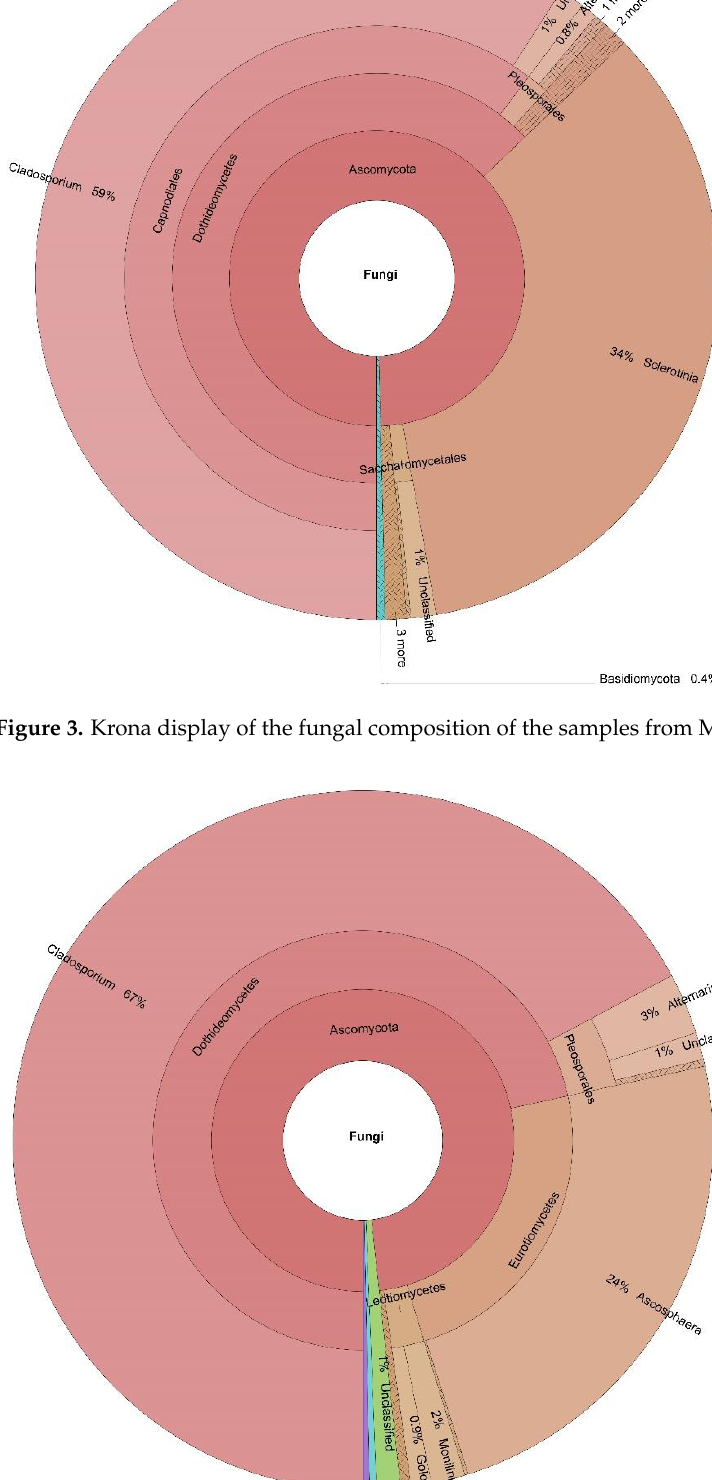
Figure 2. Krona display of the fungal composition of the samples from Dushantzi.